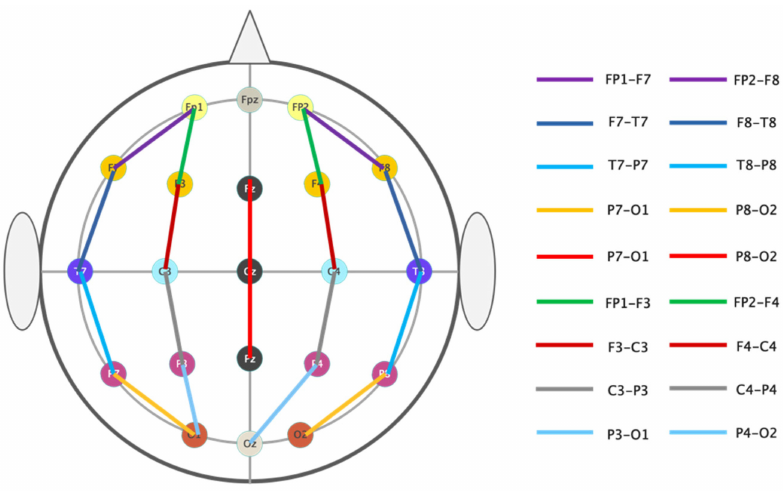
Figure 4. The electrode distribution of EEG signals.